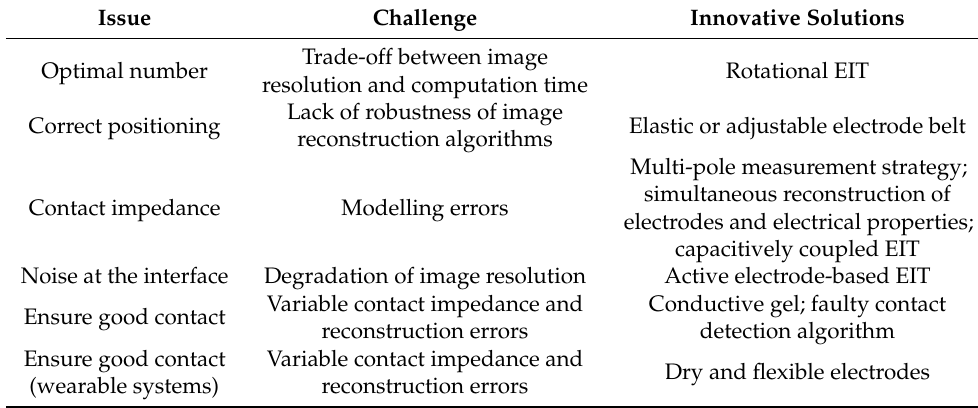
Table 2. Issues, challenges and innovative solutions found in the choice and design of electrodes.